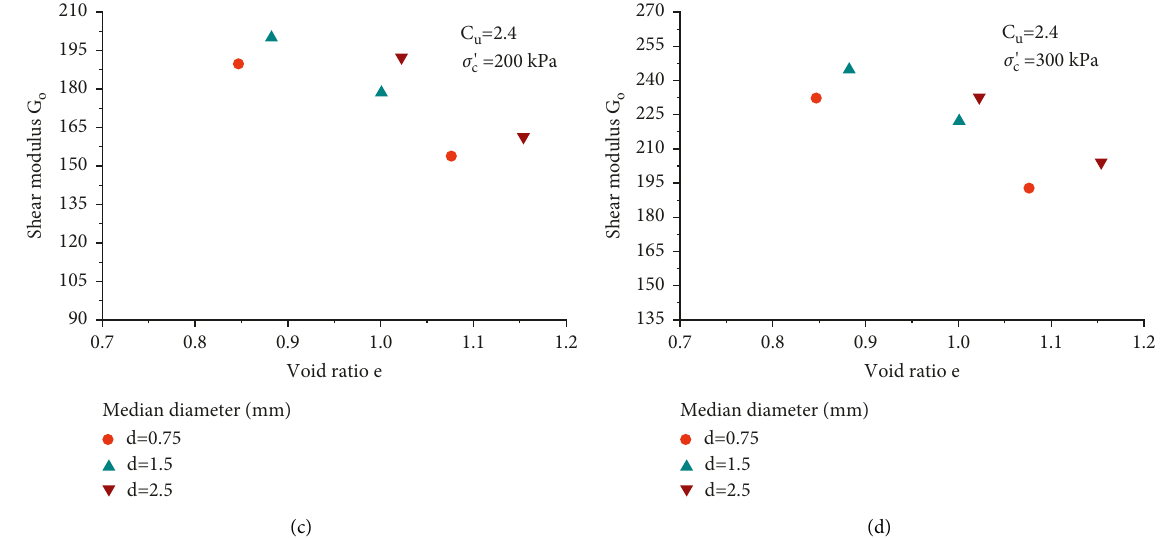
Figure 11: The maximum shear modulus and void ratio for calcareous sand with Cu � 2.4. (a) 50 kPa, (b) 100kPa, (c) 200kPa, and (d)